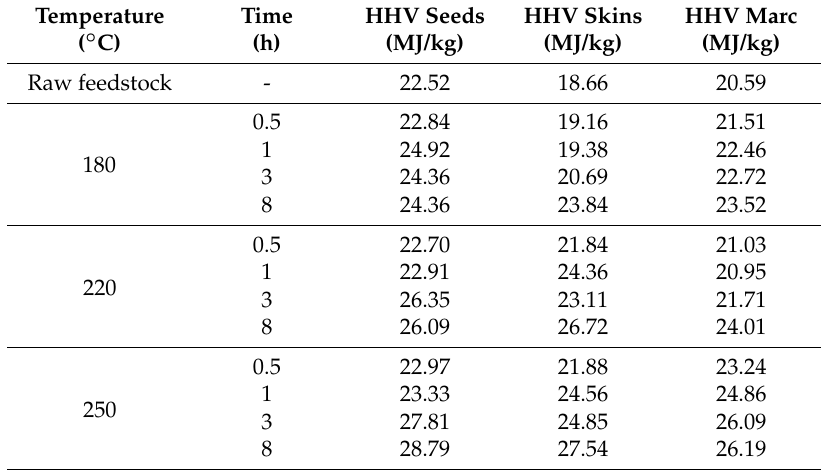
Table 2. Heating values of grape seeds, skins and marc at different process